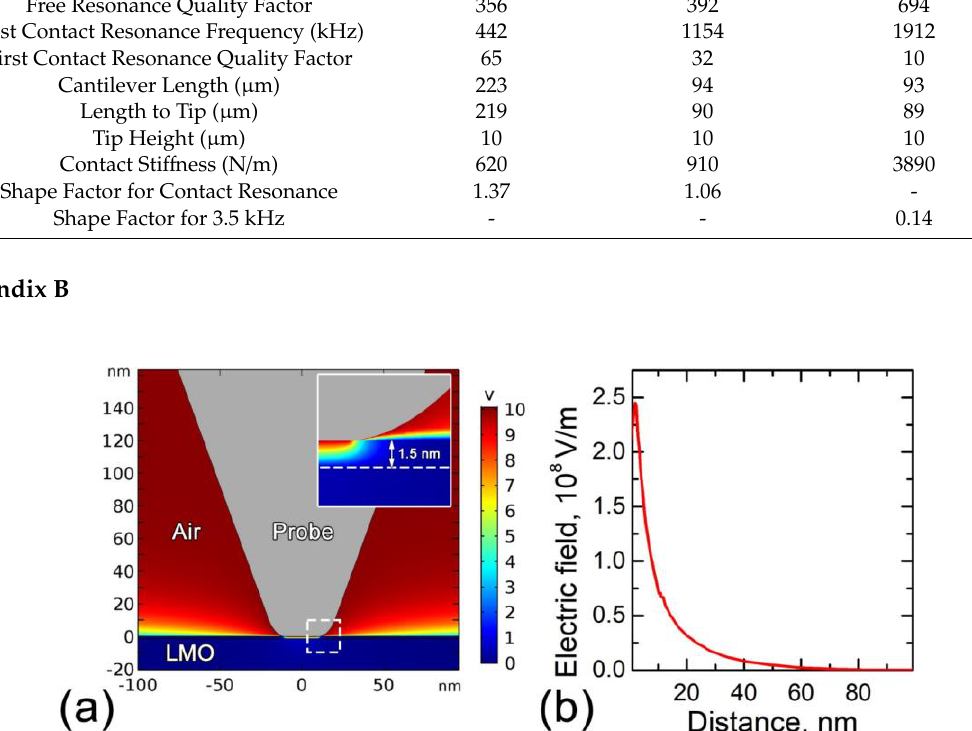
Figure A1. Finite element modeling of the local electrostatic forces in a LiMn 2 O 4 particle for the AFM probe with the 3.5 N/m spring constant: ( a ) Distribution of the electric potential. ( b ) Electric field distribution in dependence on the distance from the contact (electric field strength values at the tip-sample contact line were limited by 5 × 10 8 V/m following the approach in [42]). The resulting probe tip displacement is 0.01 pm/V.